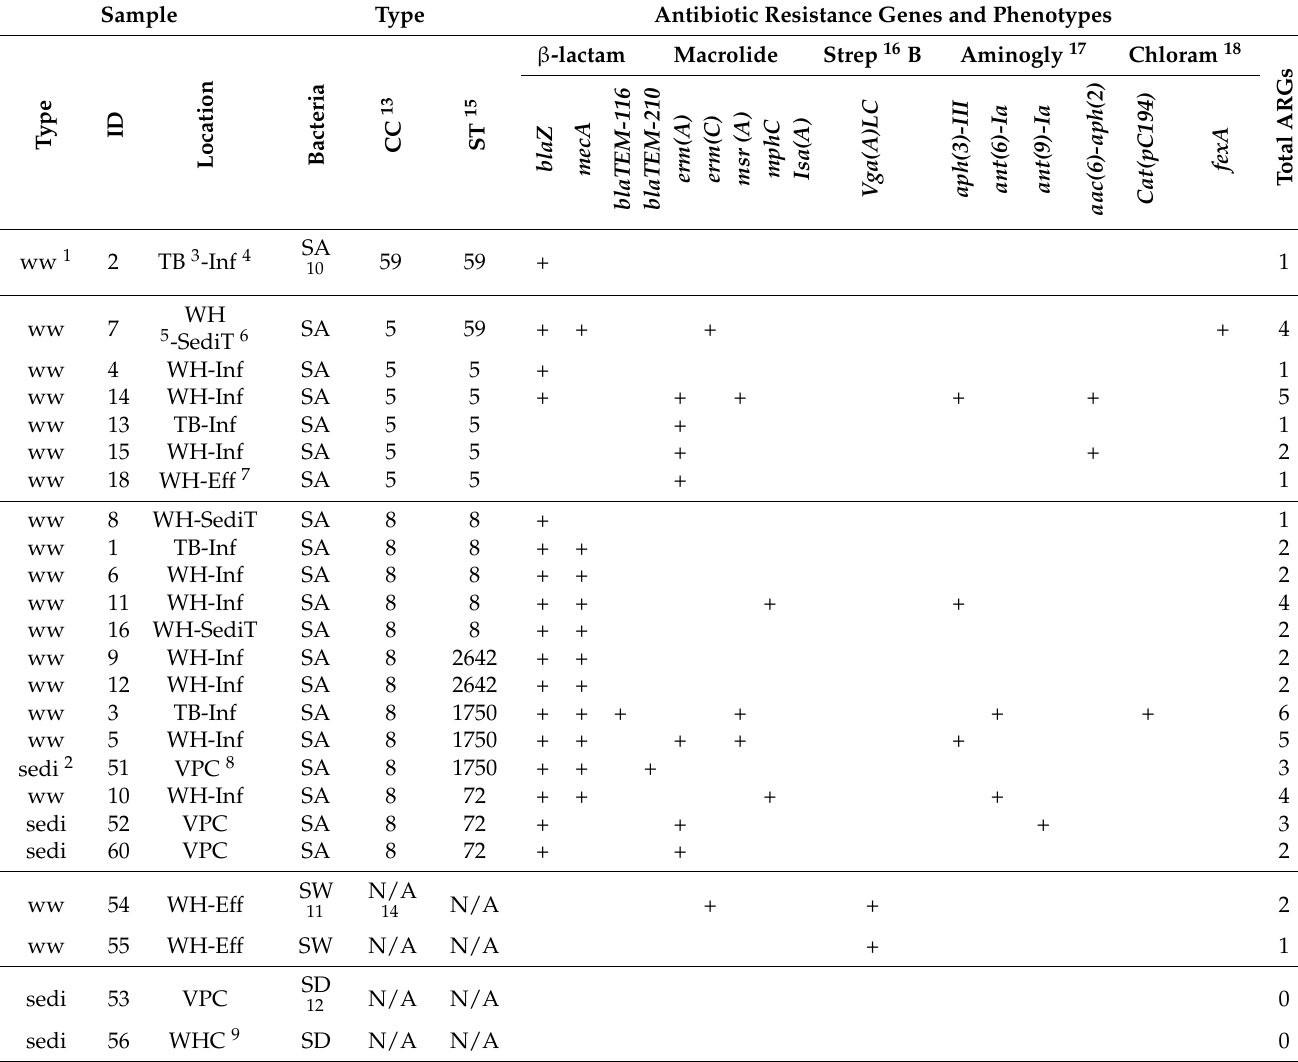
Table 1. Type of antibiotic resistance genes in sewage-associated staphylococcus species. Sample